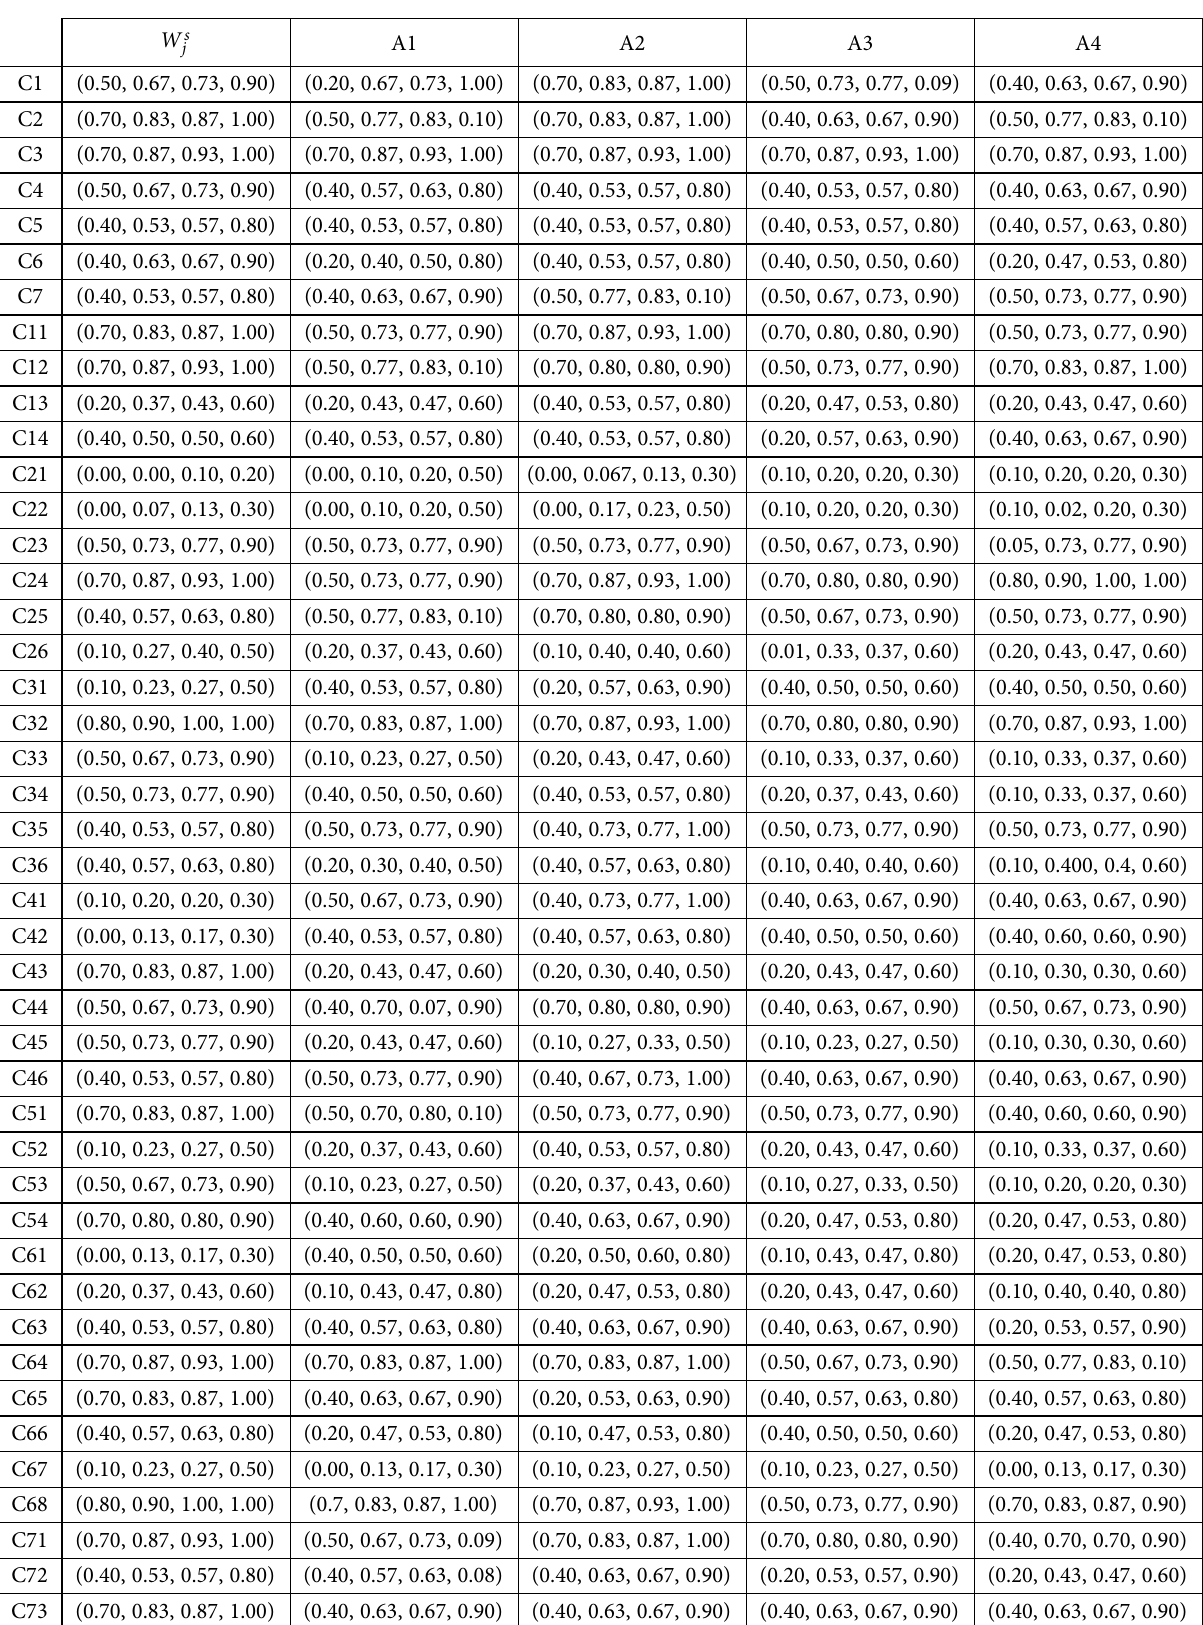
Table 7. Aggregated fuzzy values of alternatives rates and subjective importance